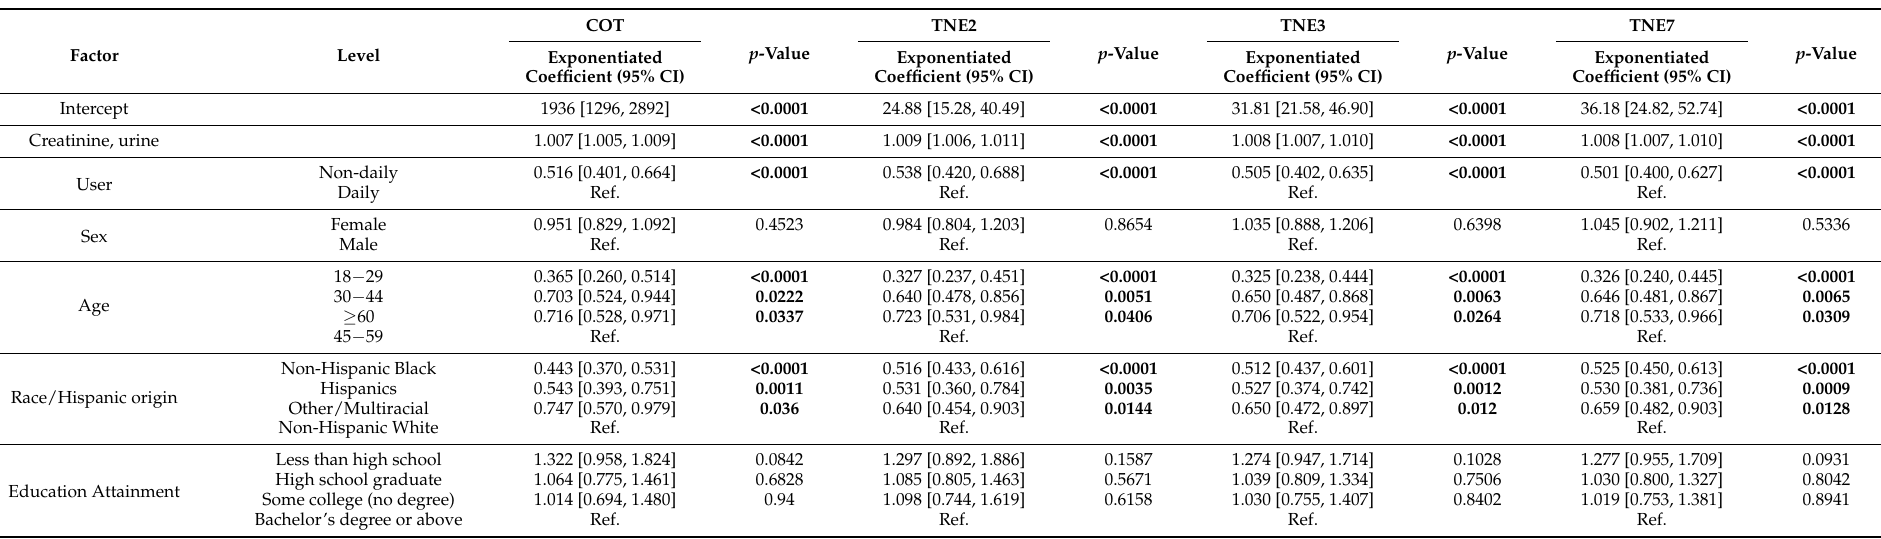
Table 5. Sample-weighted log-linear regression results for urinary cotinine ( µ g/L) and TNEs ( µ mol/L) on frequency of tobacco usage and demographic factors among people who use tobacco, from NHANES